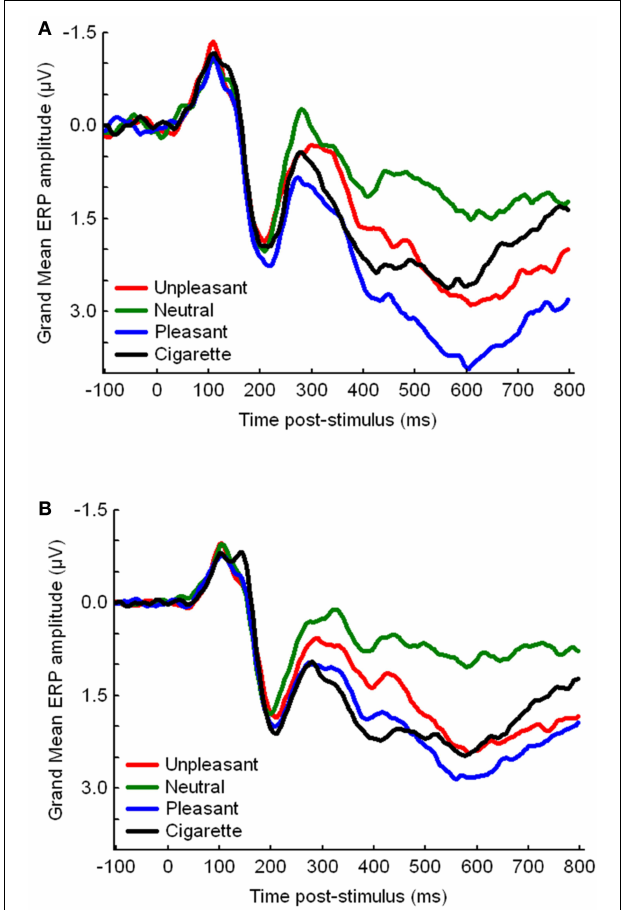
FIGURE 3 | Event-related potential waveforms, by picture category, for CHRNA3 rs578776 (A) carriers of the protective minorT allele (T/T, C/T) and (B) those homozygous for the at-risk C allele (C/C) .